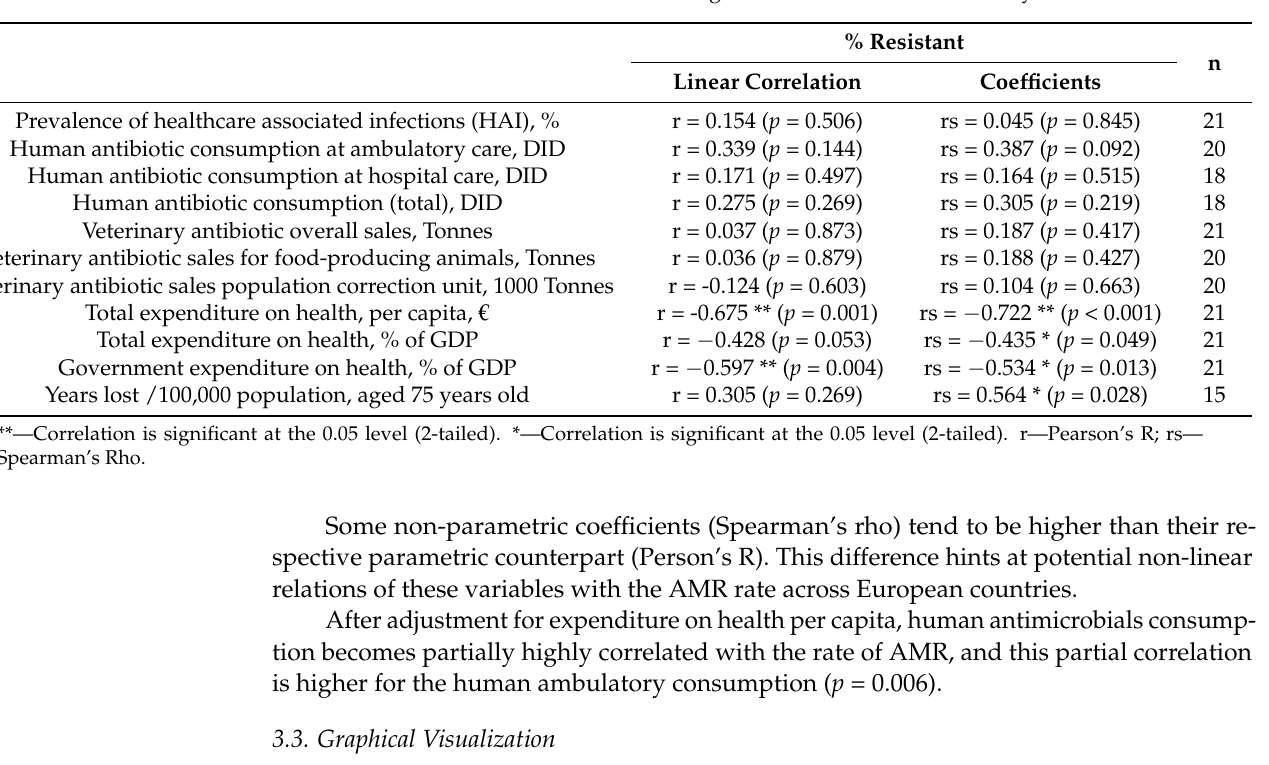
Table 2. Percentual AMR Correlation with the remaining variables included in the study.